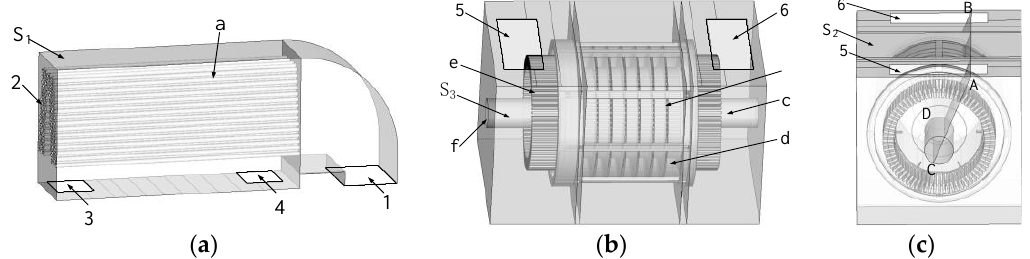
Figure 3. 3D fluid-thermal coupling calculation model for HVLSSR-PMSM: ( a ) cooler; ( b ) motor; ( c ) Circumferential view of motor. 1-Out loop air inlet, 2-Out loop air outlet, 3-Inner loop air inlet of cooler, 4-Inner loop air outlet of cooler, 5-Inner loop air outlet of motor, 6-Inner loop air inlet of motor, a-Aluminum tubes, b-Stator radial duct, c-Shaft, d-Stator core, e-Stator winding, f-Shell. In order to avoid the instability of the computation, structured grid is used in the model. The hexahedron mesh is adopted for more than 90% in the model. The cells number is 4,466,880. The calculation model is established by using software Gambit. The flow and temperature in the motor are obtained from the CFD software Fluent (Fluent 14.5, ANSYS, Pittsburgh, PA, USA). The solving domain of HVLSSR-PMSM is meshed, as shown in Figure 4.